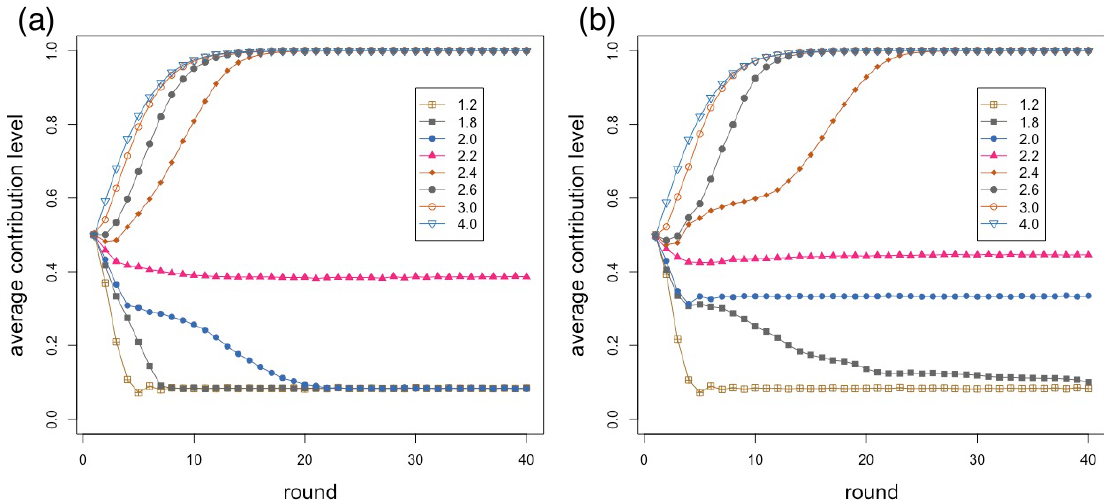
Figure 7. Average contribution as a function of round number for several values of the enhancement factor r as shown in the inset: ( a ) mean degree four; and ( b ) mean degree twelve. The average is over 40 independent repetitions of 40 rounds each on a network of size